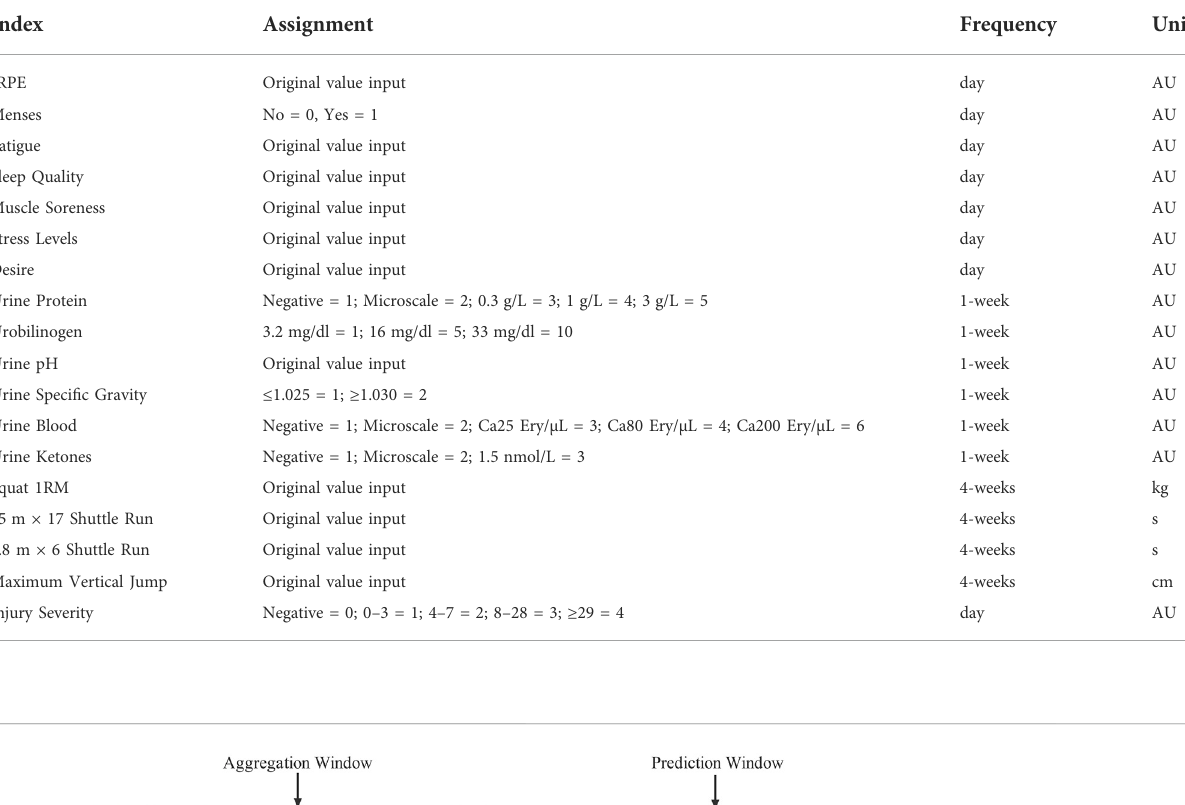
TABLE 1 Assignment of indices and units.